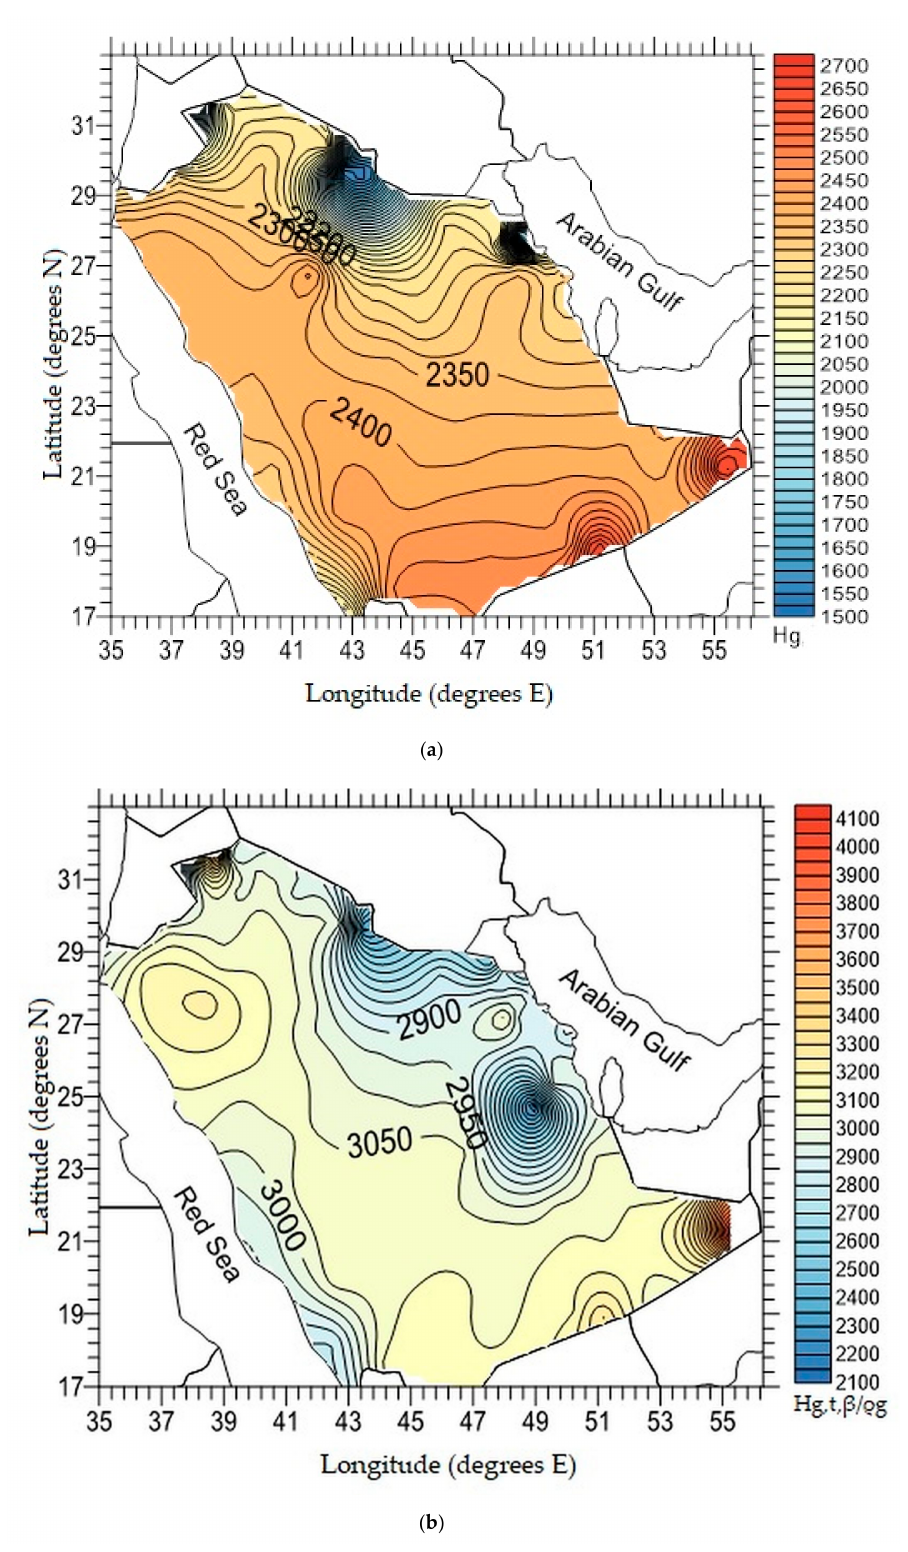
Figure 8. Distribution of the annual ( a ) H g (kWhm − 2 year − 1 ) and ( b ) H g,t, β / ρ g (kWhm − 2 year − 1 ) sums over Saudi Arabia, under all-sky conditions and averaged over the period 2005–2016. The different colouring in the H g levels is due to the different colour scales used. Figure 8a is reproduction of Figure 7a in